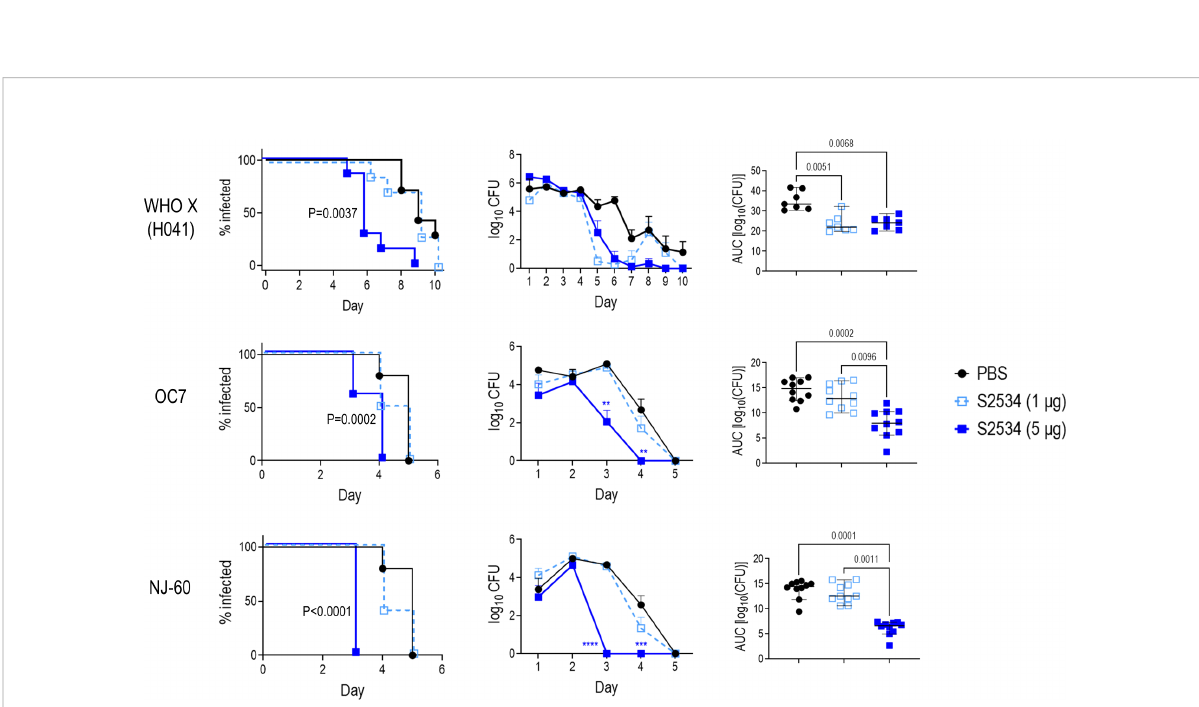
FIGURE 9 Ef fi cacy of S2534 (Fc3/FH*) against three strains of N. gonorrhoeae . Premarin ® -treated 6 week-old human FH/C4BP transgenic mice were infected with strains WHO X (H041) ( top row ; inoculum 2.5 x 10 7 CFU; n = 7 mice/group), OC7 ( middle row ; inoculum 3.8 x 10 7 CFU; n = 10 mice/group) or NJ60 ( bottom row ; inoculum 3.2 x 10 7 CFU; n = 10 mice/group) and treated daily (starting 2 h before infection) intravaginally either with PBS (vehicle control) or with 1 or 5 µg of S2534. Left graphs : Kaplan Meier curves showing time to clearance, analyzed the Mantel- Cox (log-rank) test. P values indicate comparisons between the PBS and 5 µg groups. Middle graphs : log 10 CFU versus time. X-axis, day; Y-axis, log 10 CFU. Comparisons of the CFU over time between each treatment group and the respective saline control was made by two-way ANOVA. Right graph : Bacterial burdens consolidated over time (Area Under the Curve [log 10 CFU] analysis). The three groups were compared by one- way ANOVA using the non-parametric Kruskal-Wallis equality of populations rank test. The c 2 with ties were 11.78 (P = 0.0007), 17.11 (P = 0.0002) and 19.61 (P < 0.0001) for WHO X (H041), OC7 and NJ60, respectively. Pairwise AUC comparisons across groups was made with Dunn ’ s multiple comparison test and the signi fi cant P values are